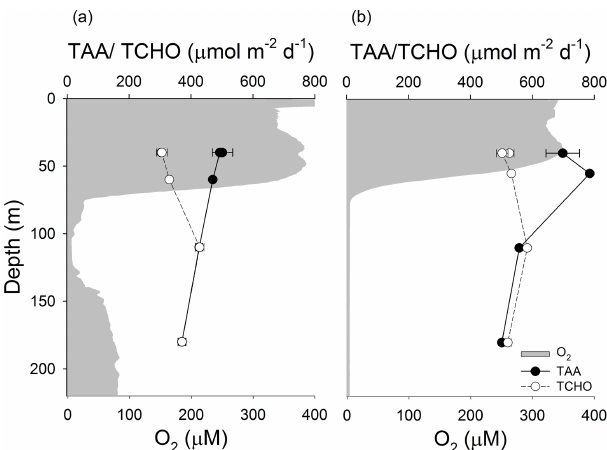
Figure 7. Vertical fluxes of total hydrolyzable amino acids (TAAs) and total carbohydrates (TCHOs) as well as oxygen concentration in (a) GB and (b)